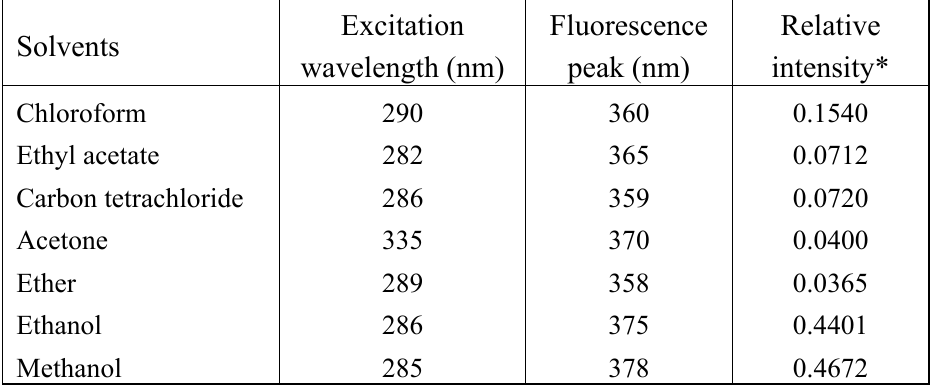
Table 2 . Fluorescence peaks of 2- N -ethylaminopyrimidine in various